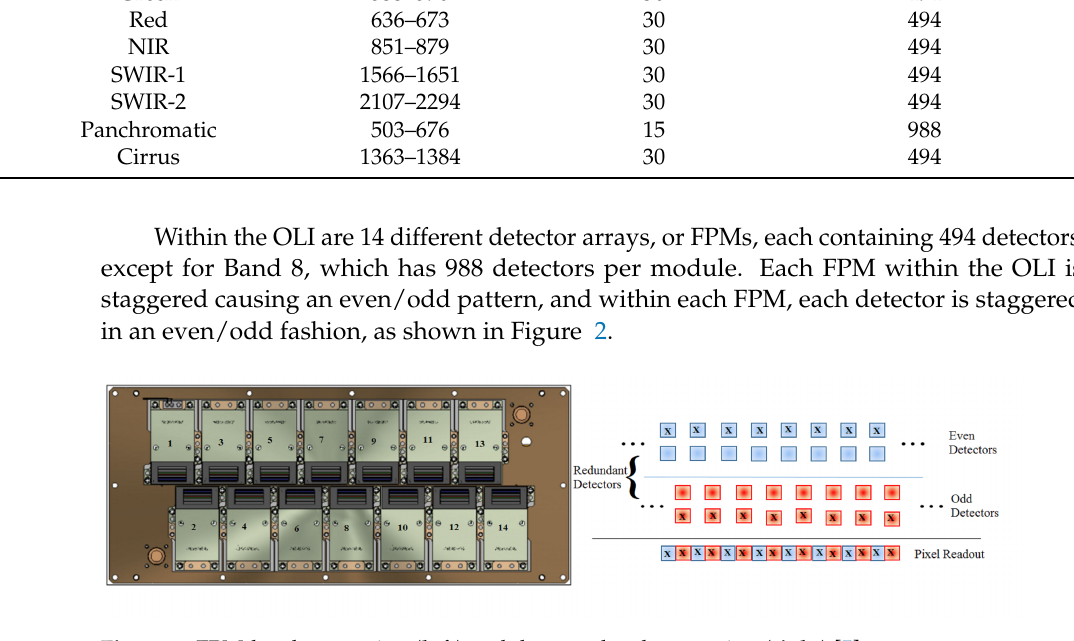
Figure 2. FPM-level staggering ( left ) and detector-level staggering ( right )